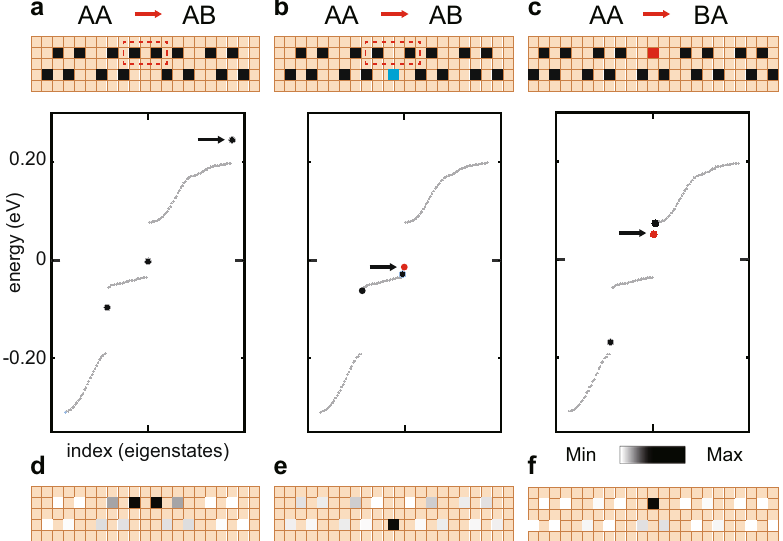
Fig. 2 Topological and trivial domain wall states in coupled dimer chains. a – c Atomic con fi gurations and corresponding energy spectra of domain walls: a , b AA → AB and c AA → BA. The atomic con fi gurations in a and b have the same domain walls as Fig. 1a, b, respectively. Red dashed rectangles indicate the difference on the upper chains between a and b . Red, black, and gray dots in the energy spectra represent topological, trivial domain wall states, and bulk states, respectively. d – f Simulated local density of states (LDOS) maps of a – c at the energy levels indicated by black arrows in a – c . Black (white) denotes the highest (lowest)